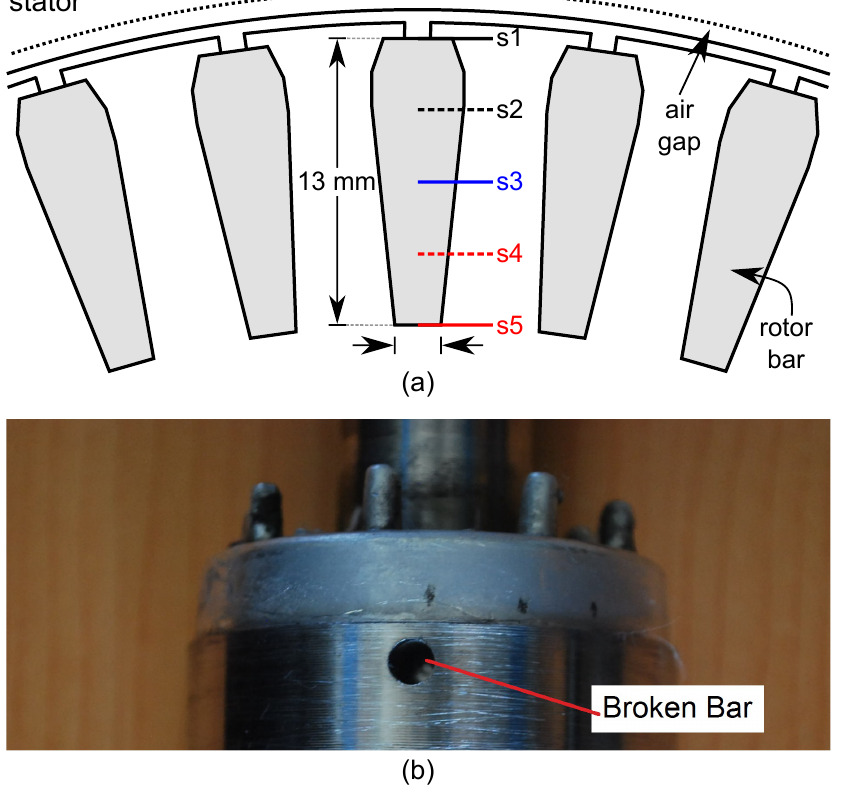
Figure 2. View of the rotor employed in the tests: ( a ) side view schematic for the transverse section of the squirrel cage rotor, and ( b ) squirrel cage rotor with a complete broken rotor bar condition.